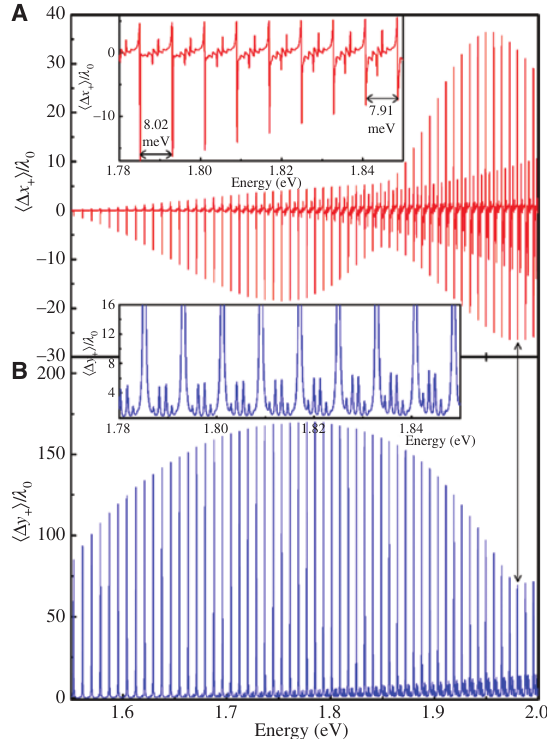
Figure 4: (A) In-plane and (B) transverse spin-dependent shifts on the surface of monolayer BP film as a function of the photonic = 55.6 ° . energy when B = 10 T and θ i The insets show partially magnified photonic spin Hall shifts for clarity. The arrow pointing top and bottom indicates that both ⟨ Δ x ⟩ + and ⟨ Δ y ⟩ give one of their extreme values at about 1.980 + period is similar to that of ⟨ Δ x ⟩, i.e. ⟨ Δ x ⟩ and ⟨ Δ y ⟩ show + + + peak values at nearly the same energy. For instance, both ⟨ Δ x ⟩ and ⟨ Δ y ⟩ give one of their extreme values at about + + 1.980 eV, as indicated by the arrow pointing top and bottom in Figure 4. Figure 5A and B present the in-plane and transverse spin Hall shifts as a function of the photonic energy and the incident angle when B = 10 T. In general, the in-plane